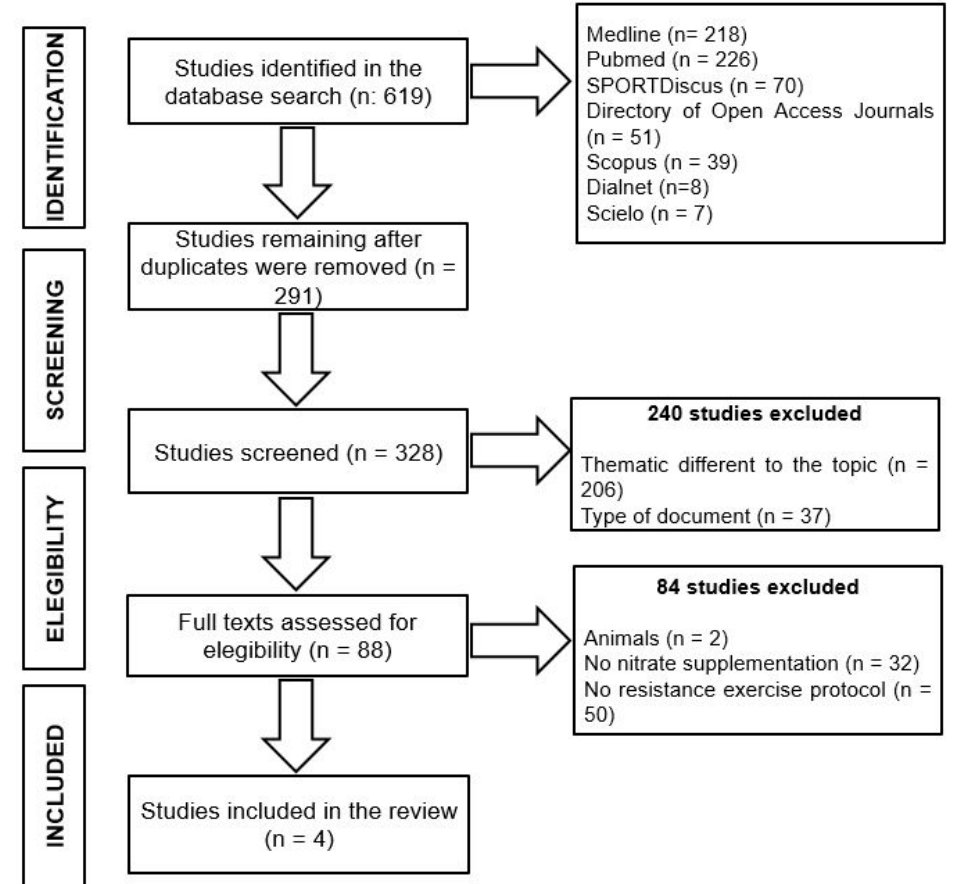
Figure 1. Preferred Reporting Items for Systematic Reviews and Meta-Analysis (PRISMA) flowchart.